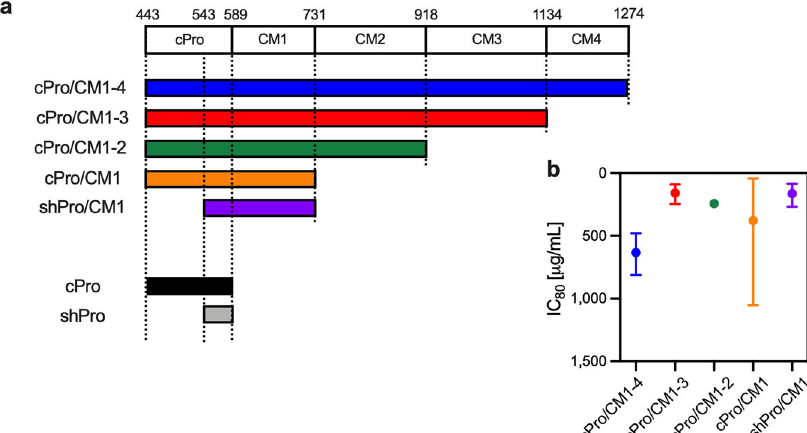
Fig. 1 Pfs230 constructs and antibodies used in this study. a Pfs230 domain structure and design of constructs used in this study are shown. The numbers above Pfs230 structure bar indicate amino acid (aa) positions. CM stands for cysteine motif domain de fi ned by Gerloff et al. 5 . Within the prodomain region (aa 22-588), only areas after cleavage site (aa 443) were included for the construct design. cPro (cleaved- prodomain) means aa 443 – 588 region of Pfs230, and shPro (short prodomain region) indicates aa 543 – 588 region. b Mouse antibodies against cPro/CM1-4, cPro/CM1-3, cPro/CM1-2, cPro/CM1 and shPro/CM1 generated in the previous study 17 were tested by standard membrane- feeding assay (SMFA) at four concentrations, and total IgG concentration which gave 80% reduction in oocyst density (IC 80 ) was calculated for each antibody. The IC 80 (closed circles) and the 95% con fi dence interval (95%CI, error bars) are shown. For ease of comparing IC 80 data with per cent inhibition of oocyst density (%TRA) in other fi gures, the y -axis is